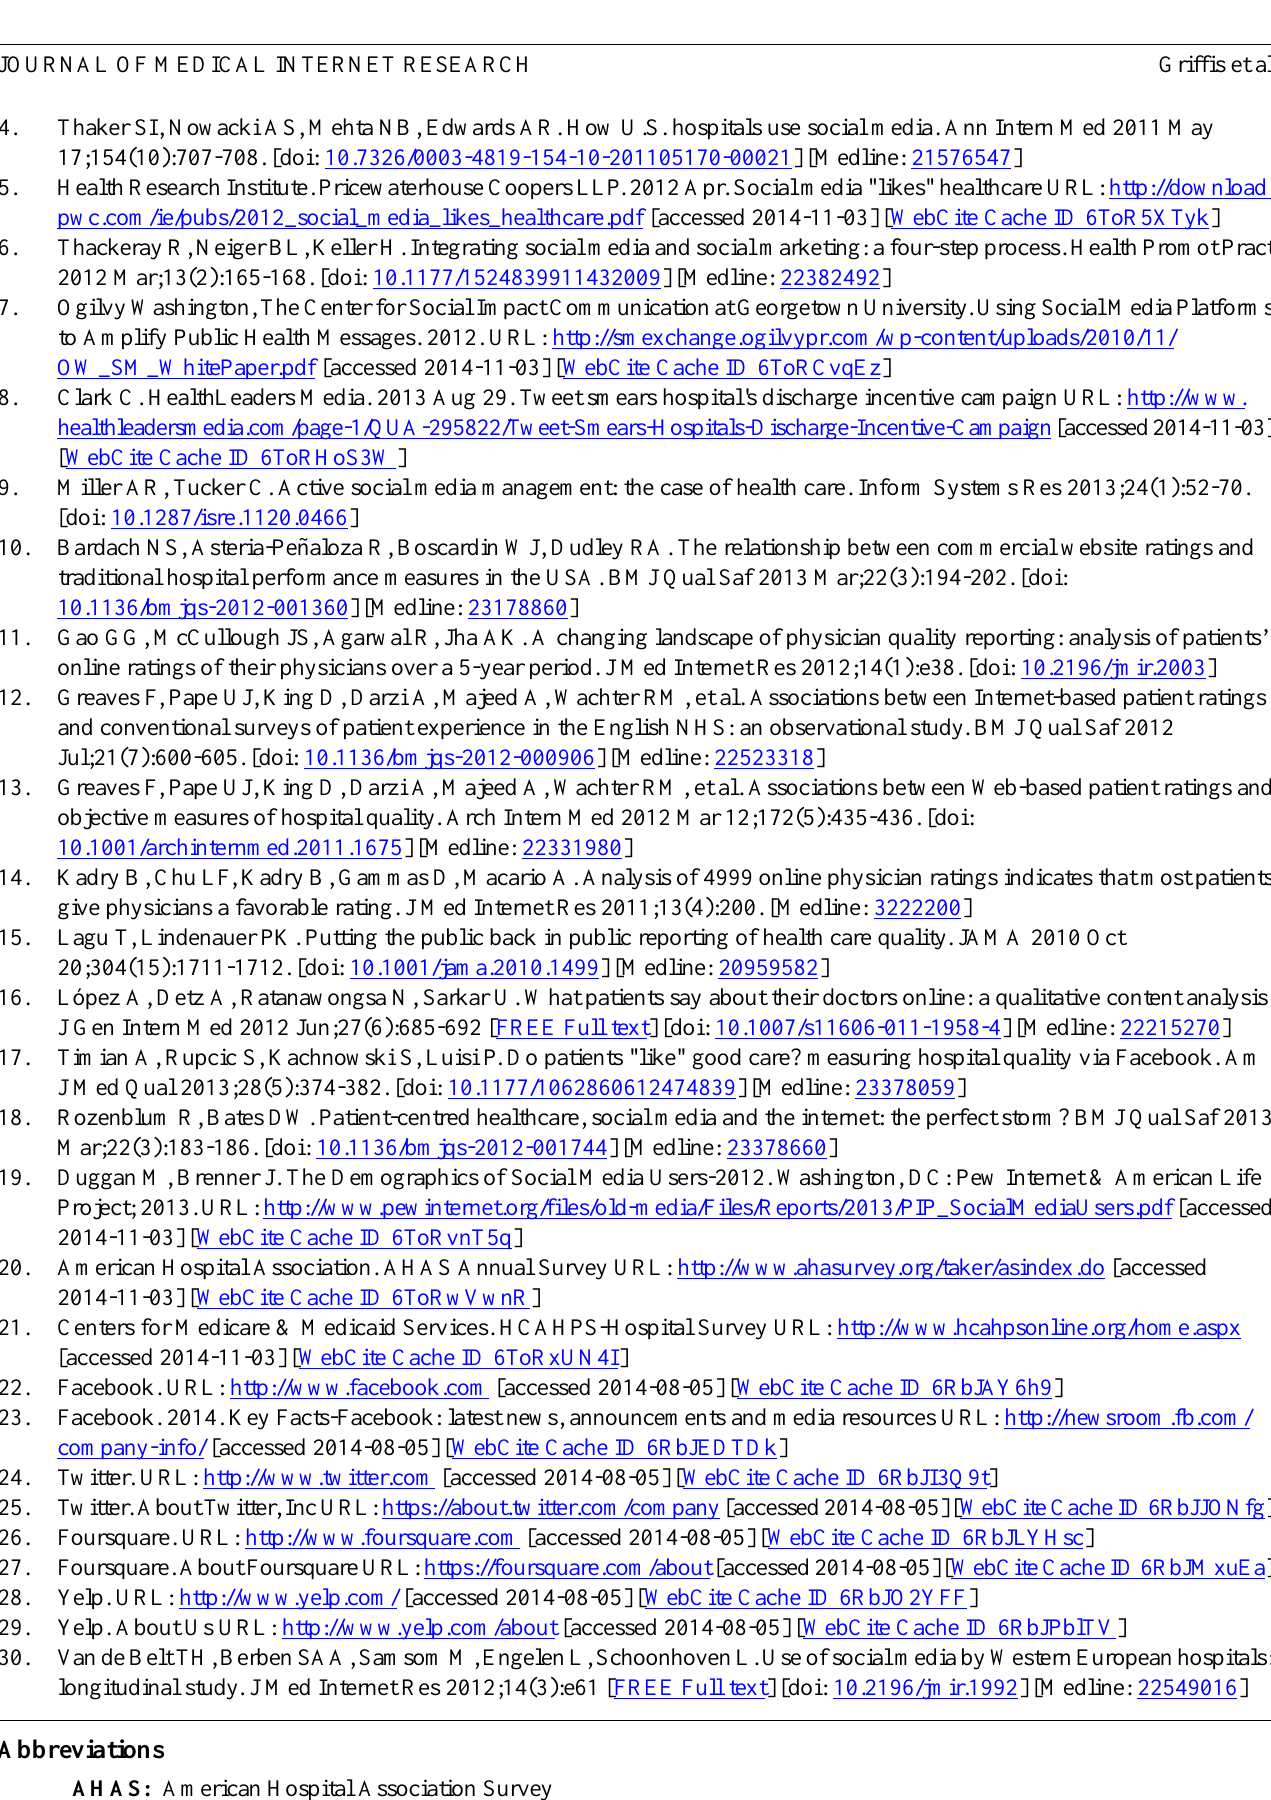
AHAS: American Hospital Association Survey HCAHPS: Hospital Consumer Assessment of Healthcare Providers and Systems OLS: ordinary least